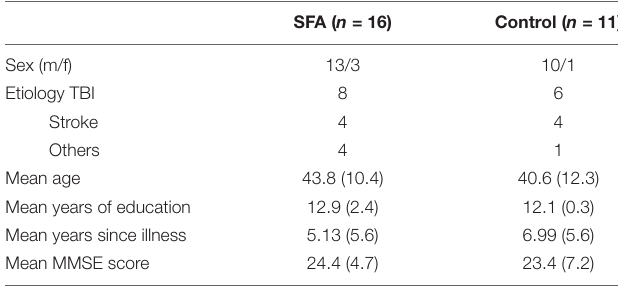
TABLE 1 | Characteristics of SFA and Control